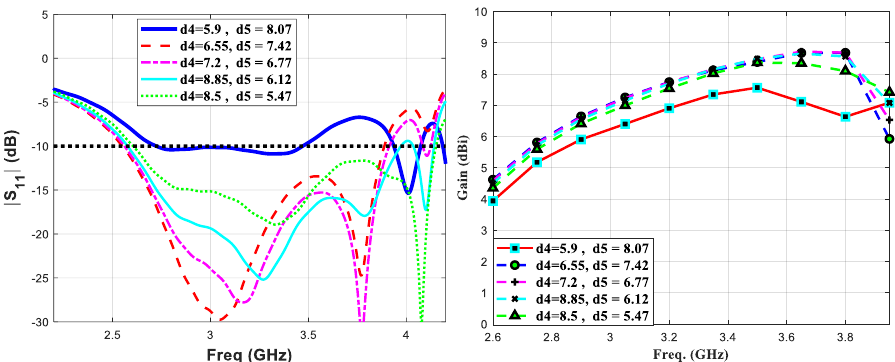
Figure 3. Parametric study of the position of the proposed directive element based on reflection coefficient and gain performance analysis.